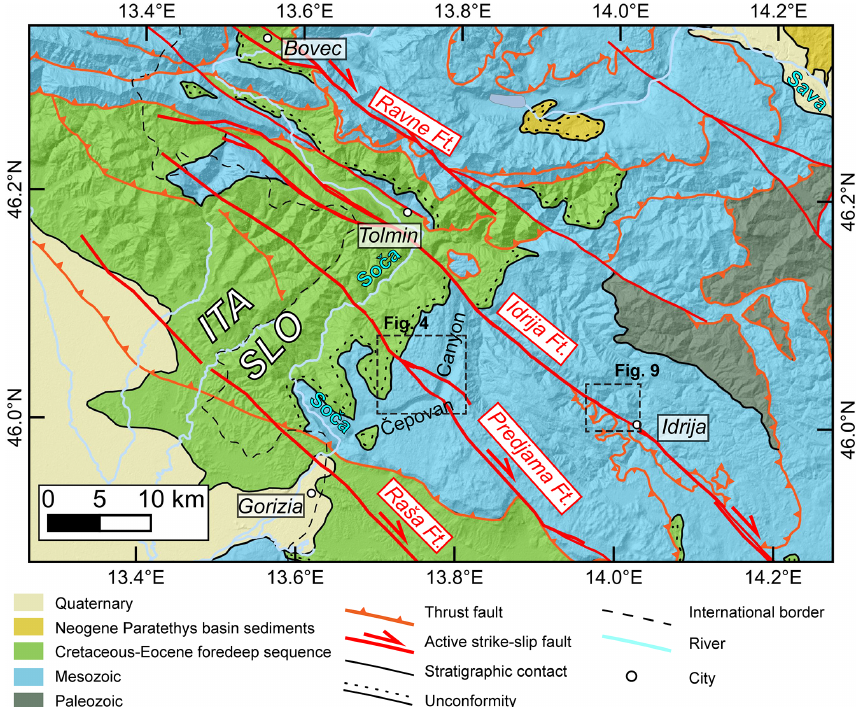
Figure 3. Geological setting of the study sites in NW Slovenia; same extent as Fig. 2. The geology is compiled from the 1:250000 geological map of Buser (2009) and the 1:150000 geological map of the Friuli Venezia Giulia region (Carulli, 2006).